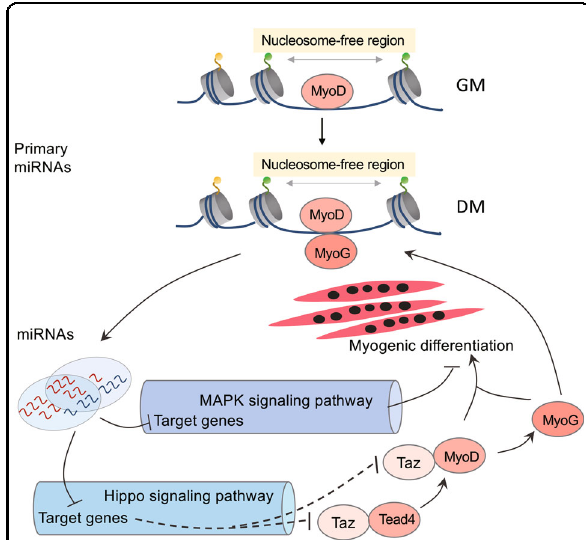
Fig. 8 miRNAs and TFs coregulatory network acting through the Hippo and MAPK signaling pathways during C2C12 myoblast differentiation. Chromatin accessibility and TFs occupancies were associated with the expression of miRNAs, miRNAs and TFs formed feedback regulation loops through the Hippo and MAPK signaling pathways to regulate C2C12 myoblast